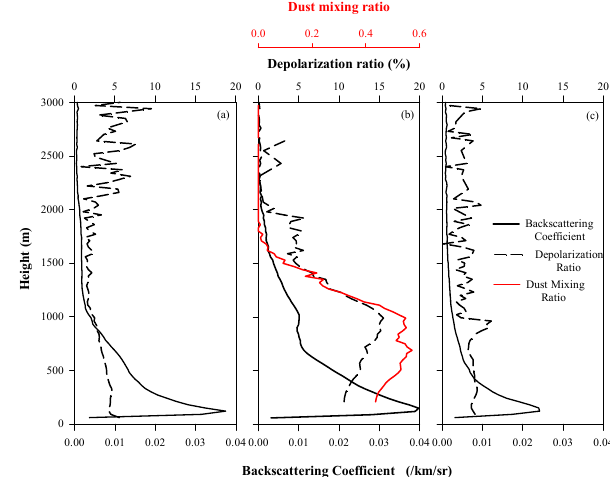
0.00 0.01 0.02 0.03